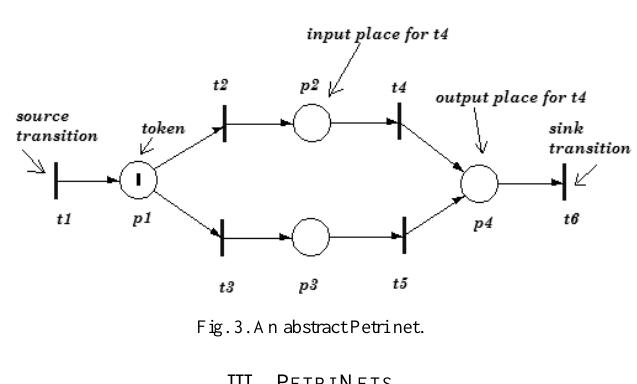
Fig. 3. An abstract Petri net. III. P ETRI N